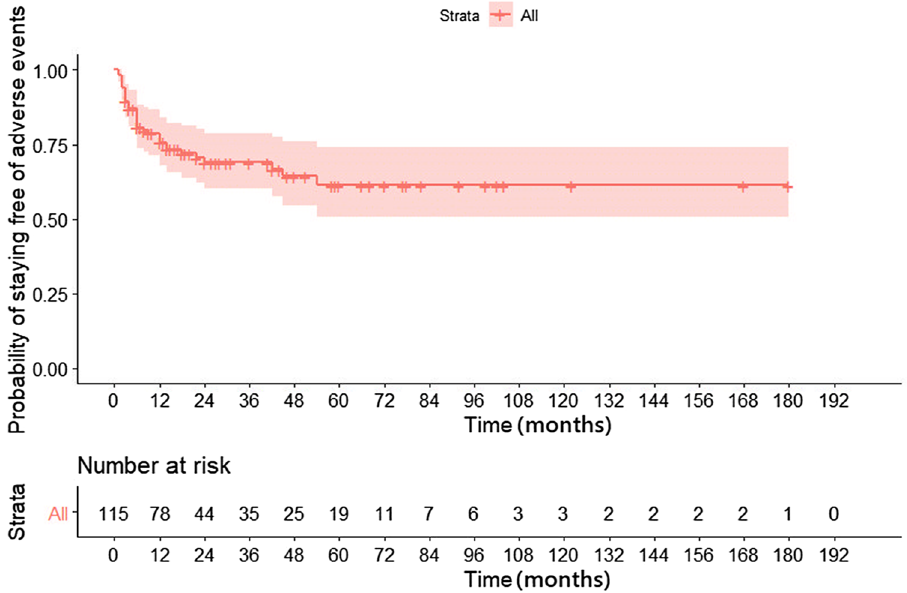
Figure 2. Kaplan Meier graph comparing treatment success between colonic strictures and small bowel strictures.